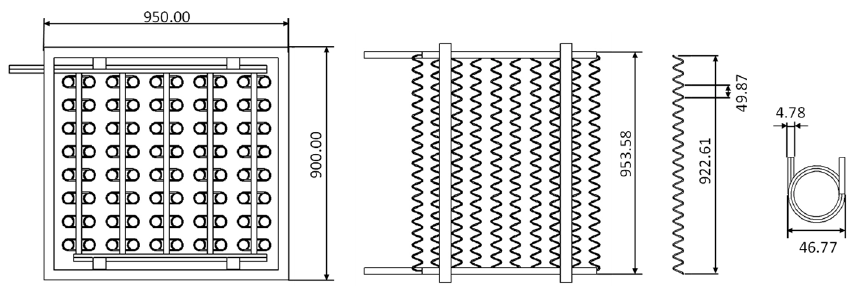
Figure 2. Design layout of the ice storage tank.